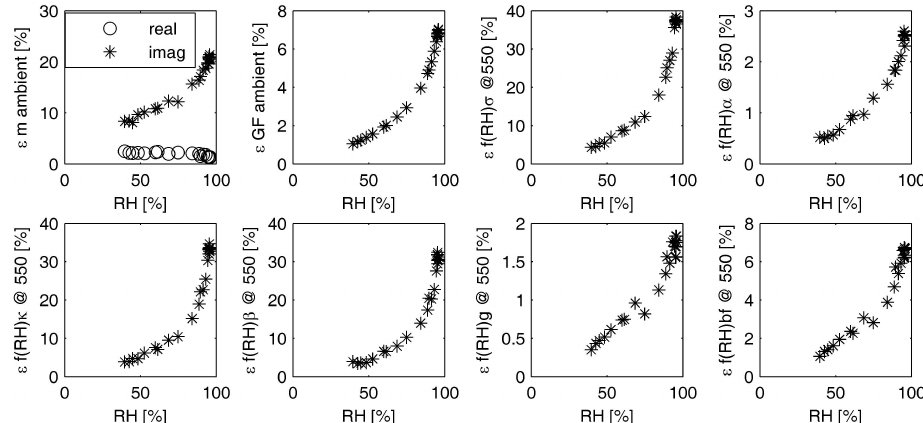
Fig. 10. The RH dependence of the uncertainty ε [%] for the retrieved refractive index, growth factor (GF) , and computed enhancement factors f (RH) for the scattering ( σ) , absorption ( α) , extinction ( κ) , backscattering ( β) coefficients, the asymmetry parameter ( g) and the backscatter fraction